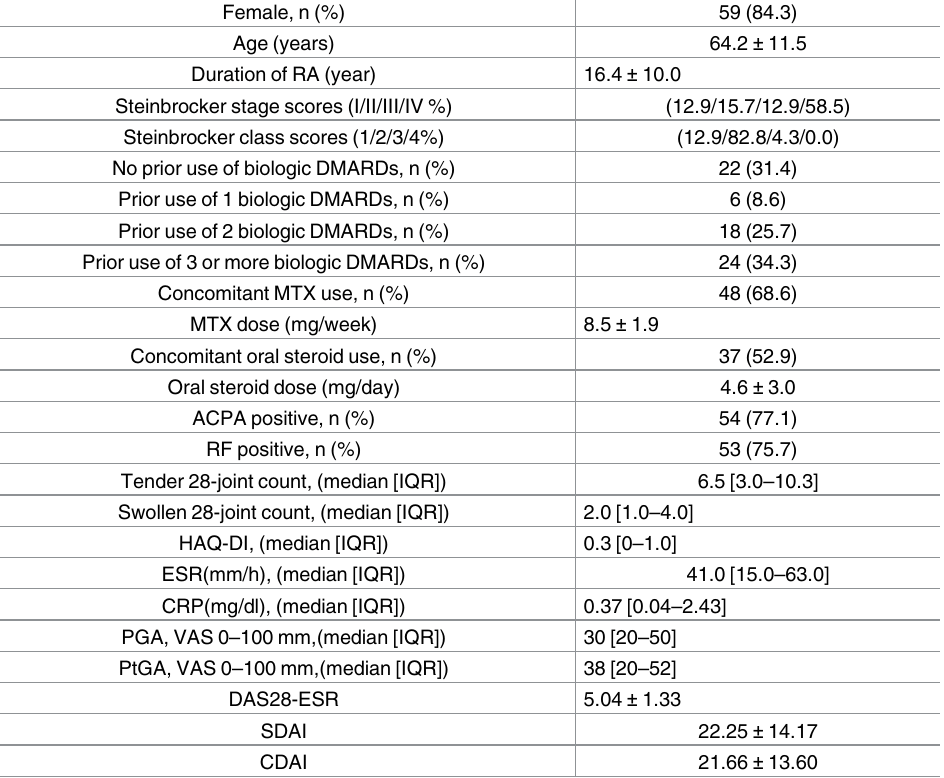
Table 1. Clinical characteristics of the study